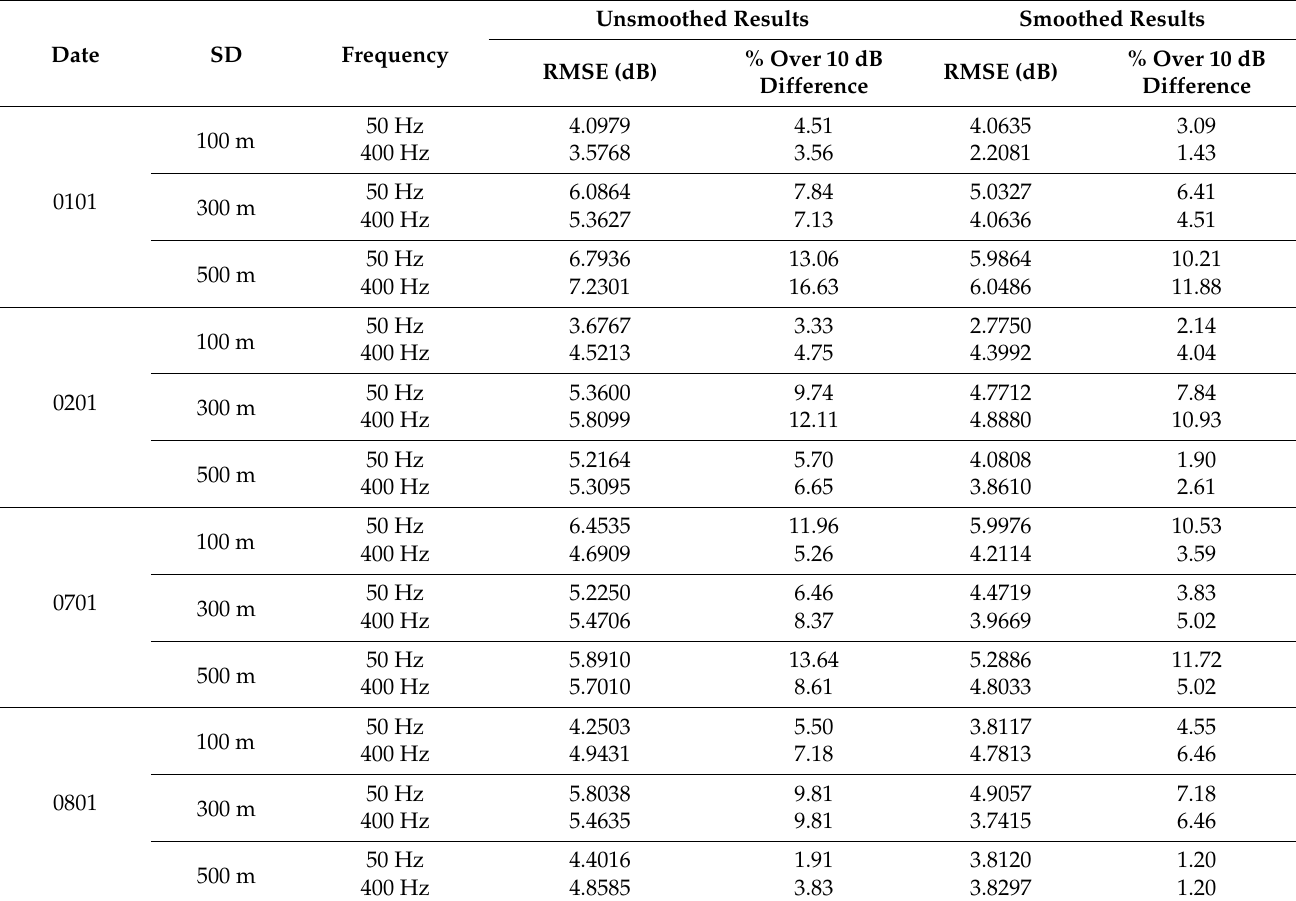
Table 2. Comparison between the TL calculated through the model and the actual situation at different times, different sound source depths, and different